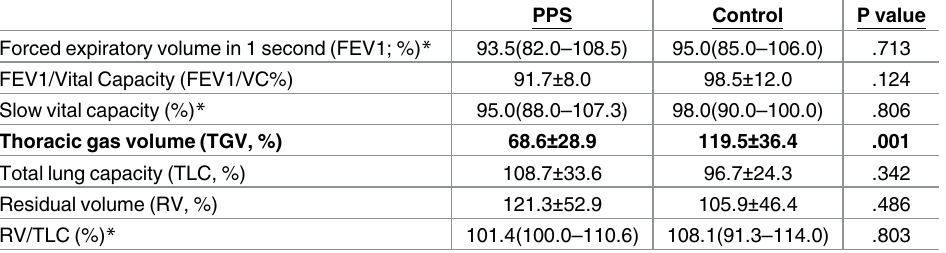
Table 2. Pulmonary function test results in the Post Polio Syndrome (PPS) group (N = 12) and the con- trol group (N = 12) presented as percent of predicted value. Valuesare presentedas mean ± standard